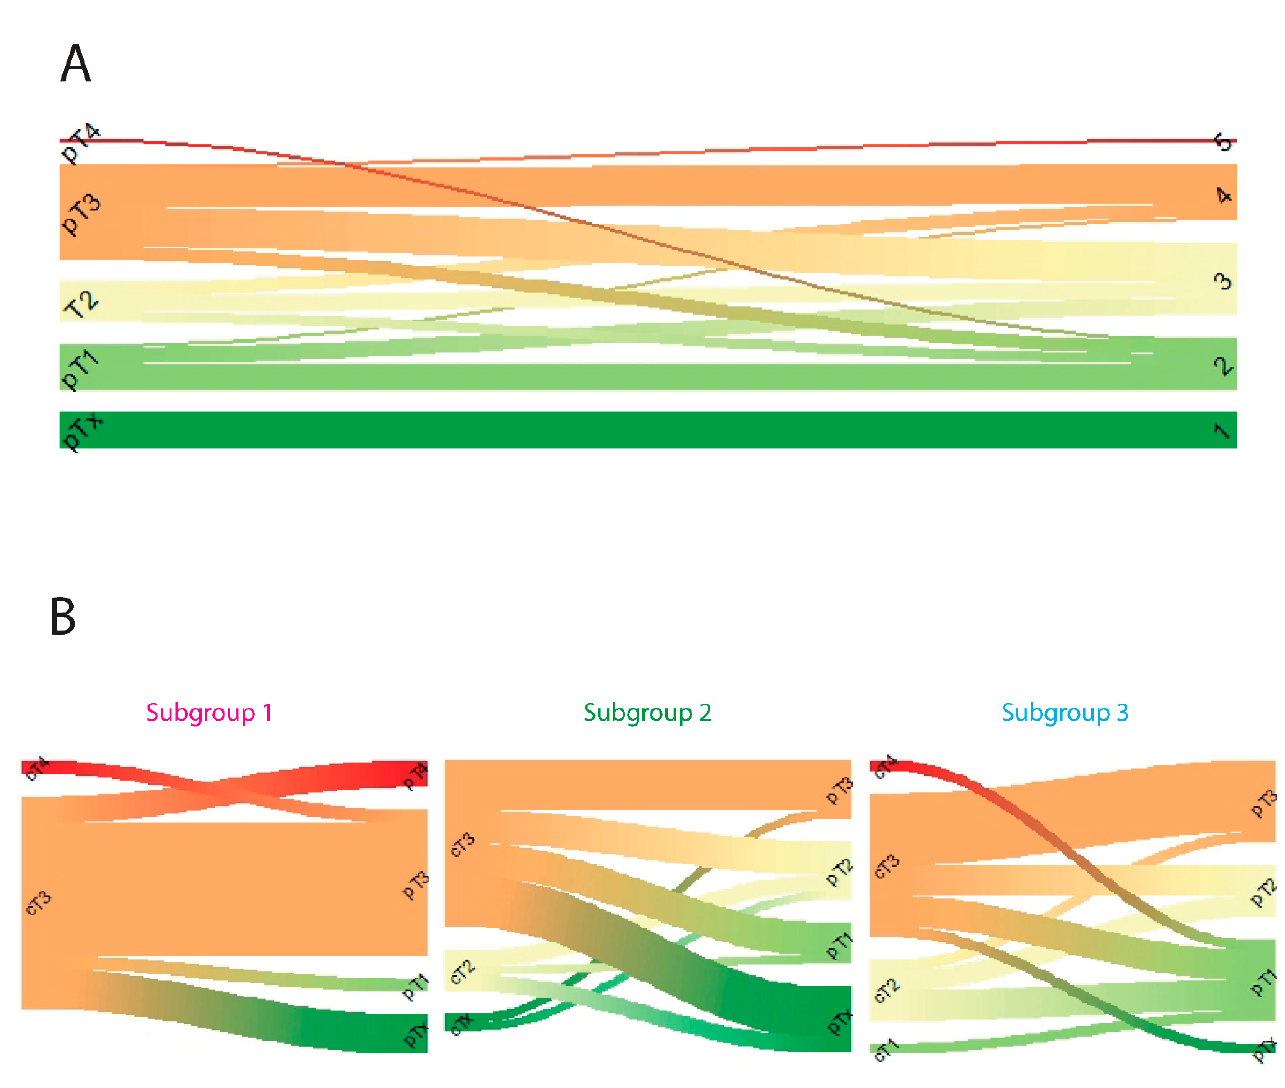
Figure 3. ( A ) pT stage and Mandard score (1, 2, 3, 4, 5) are highly correlated. ( B ) Clinical T stage and pathological T stage after neo-adjuvant treatment in 3 clusters in the AUMC